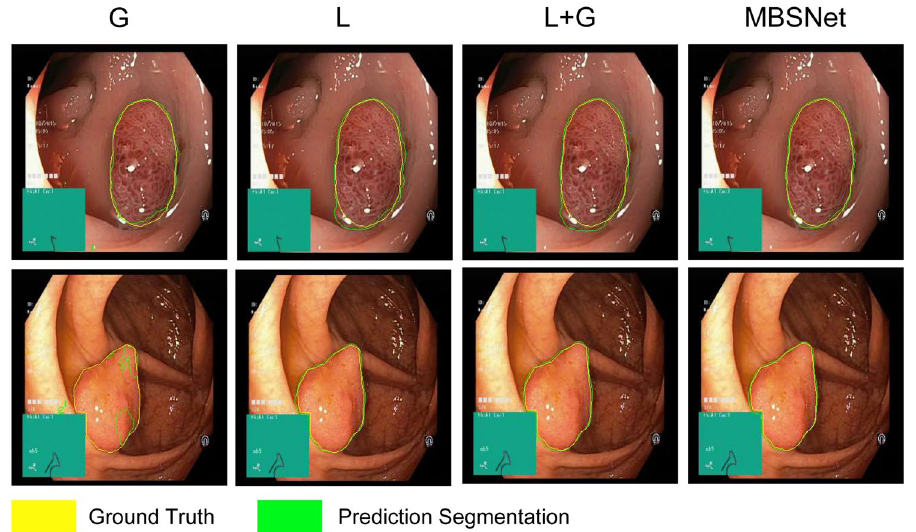
Figure 8. Visual comparison of segmentation by different branches. The level represents the prediction results of different branches of MBSNet for the same image, and the vertical is two representative images from the Kvasir dataset for analysis. The yellow and green lines in the figure represent GT and predicted segmentation results,